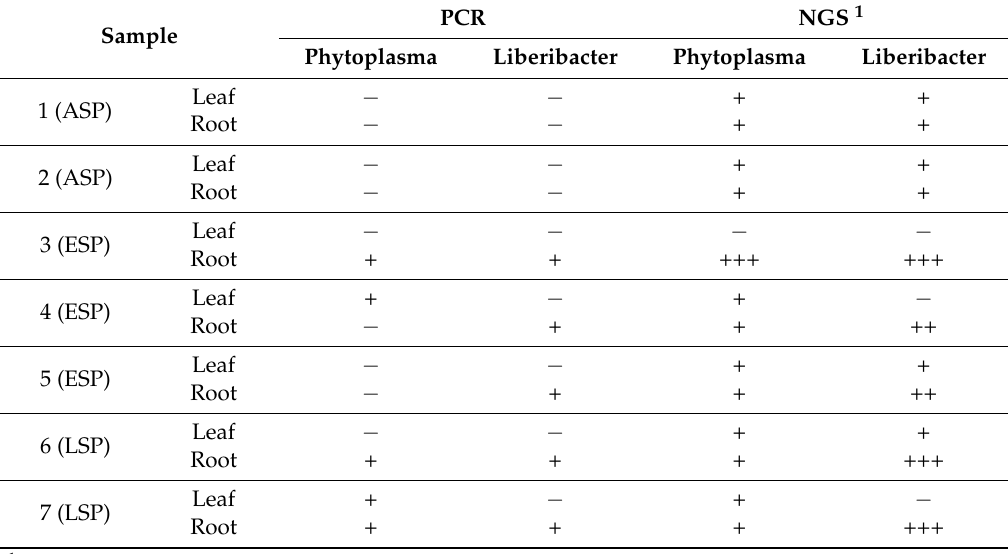
Table 1. Table reporting the results of detection of phytoplasma and liberibacter in the analyzed samples, both with PCR and with next generation sequencing